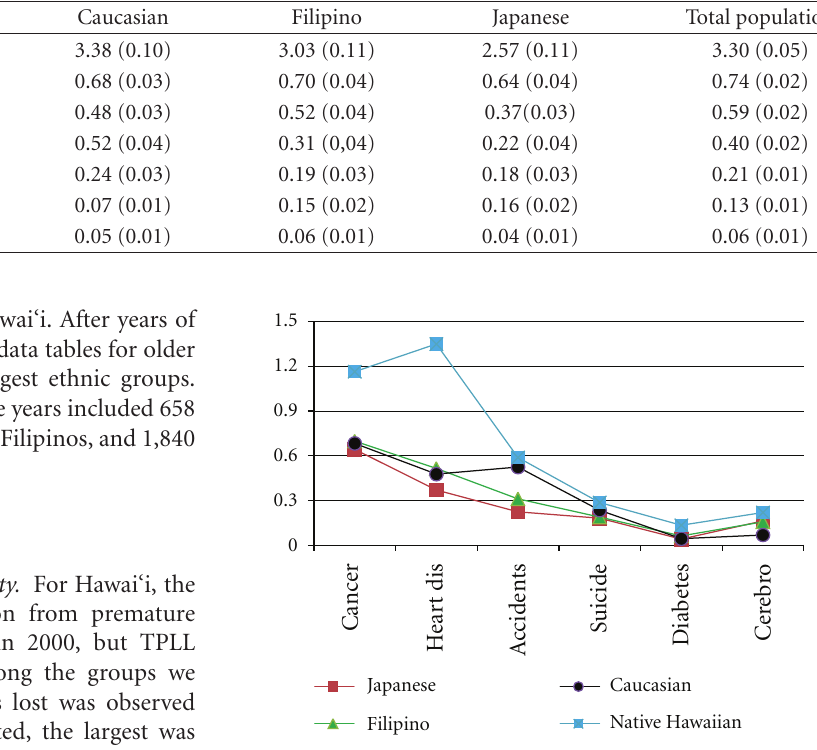
Table 2: Years of Total Potential Life Lost (TPLL) and standard errors for the total population and 4 ethnic groups by cause of death, 1991–2001.